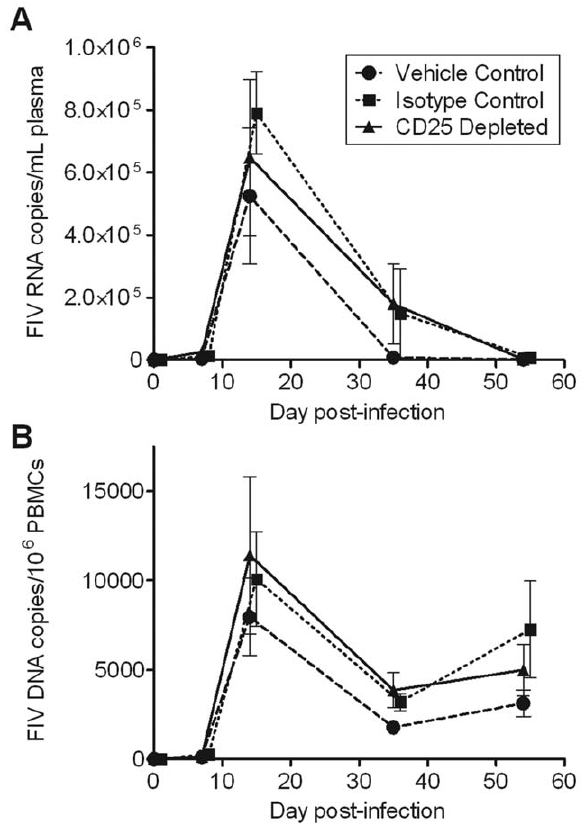
Figure 2. Anti-CD25 mAb treatment does not significantly alter FIV levels in the blood. Cats were infected with 2 6 10 5.2 TCID 50 units molecular clone FIV-C36 by intravaginal and intravenous routes on day 0. (A) To detect viremia in plasma samples, one-step quantitative real- time RT-PCR was performed on extracted RNA samples. FIV RNA copy number was quantified relative to an FIV C gag RNA standard curve. (B) Provirus in PBMCs was detected via quantitative real-time RT-PCR on extracted DNA samples. FIV copy number was quantified relative to an FIV C gag DNA standard curve, and then normalized relative to CCR5 copy number. Mean 6 SEM is shown